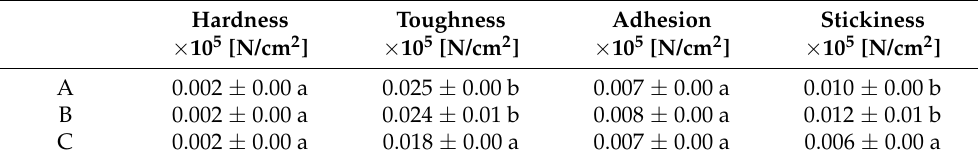
Table 5. Textural properties of three kinds of cooked rice for human test. Hardness Toughness Adhesion Stickiness × 10 5 [N/cm 2 ]